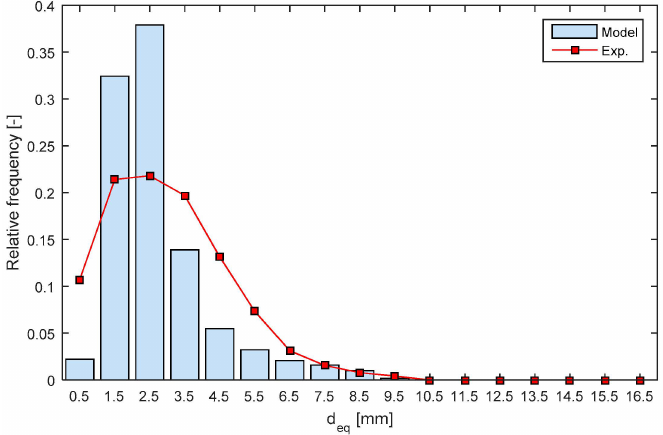
Figure 5. Comparison between PBM results and experimental data: U G = 0.0149 m/s.